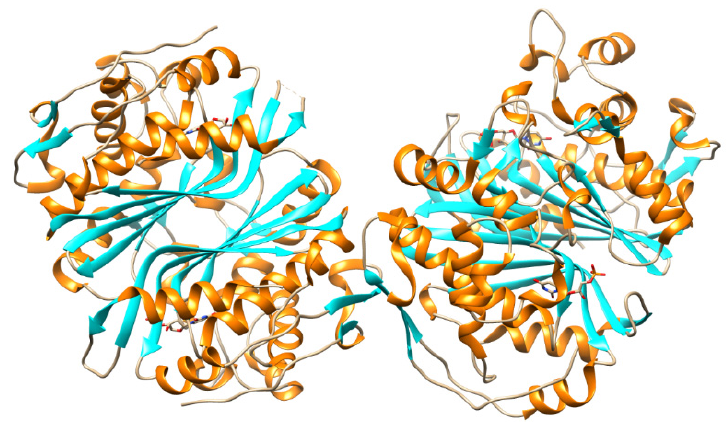
Figure 18. Structure of ThyX with 5-F-dUMP complex [106]. https://www.rcsb.org/structure/4FOA, (accessed on 21 January 2022).